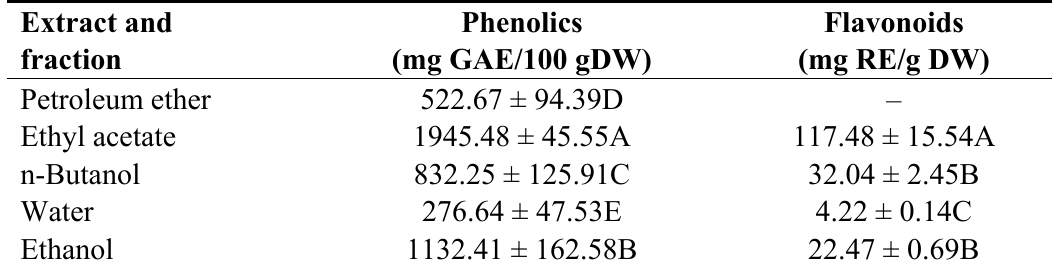
Table 4. The amount of the total phenolics and the total flavonoids in fractions of papaya